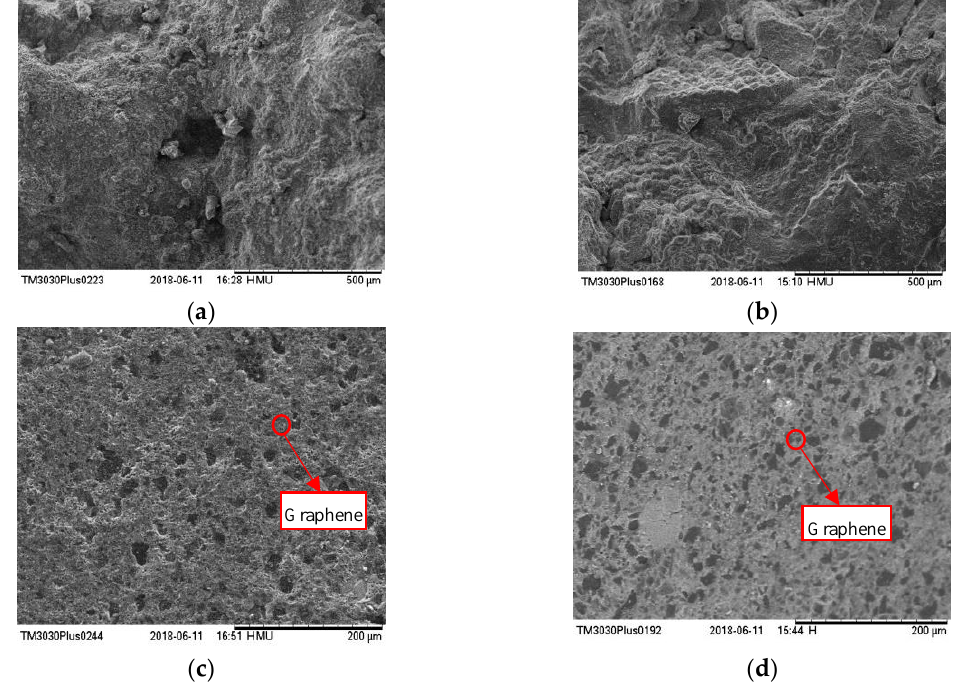
Figure 3. SEM images of nanocomposites. ( a ) HITEC salt/2 wt.% Al 2 O 3 nanopowder, ( b ) solar salt/2